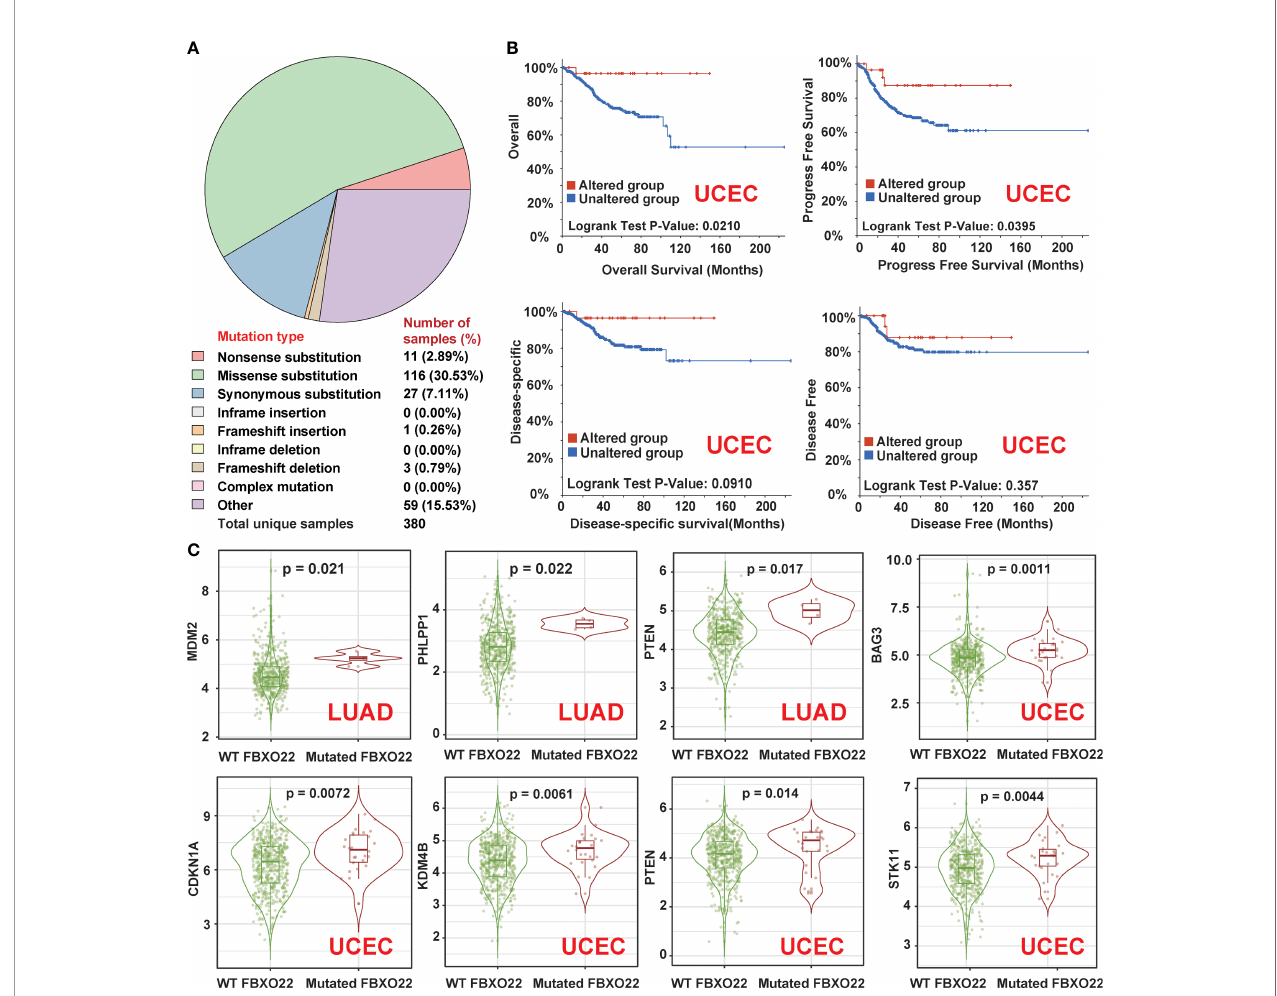
FIGURE 4 | Genetic alterations in FBXO22 in different cancer types. (A) The distribution of different types of mutation in FBXO22 displayed using the COSMIC tool. (B) Potential correlation between FBXO22 alteration status and overall, progression-free, disease-free, and disease-speci fi c survival in UCEC, as analyzed using the cBioPortal tool. (C) MDM2 , PHLPP1 , and PTEN expression in samples with wild-type or mutated FBXO22 in LUAD; CDKN1A , KDM4B , STK11 , and PTEN expression in samples with wild-type or mutated FBXO22 in